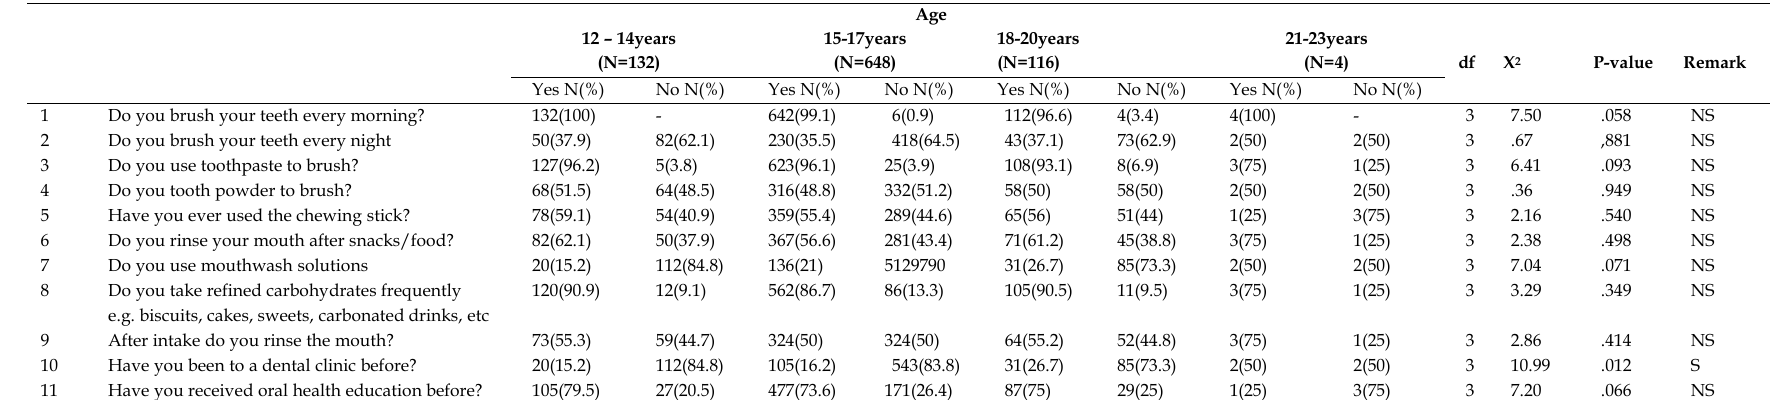
Table 4: Chi-square analysis on the difference in the preventive measures adopted by Senior Secondary School students based on age